Question: What style of plot is this figure drawn as?
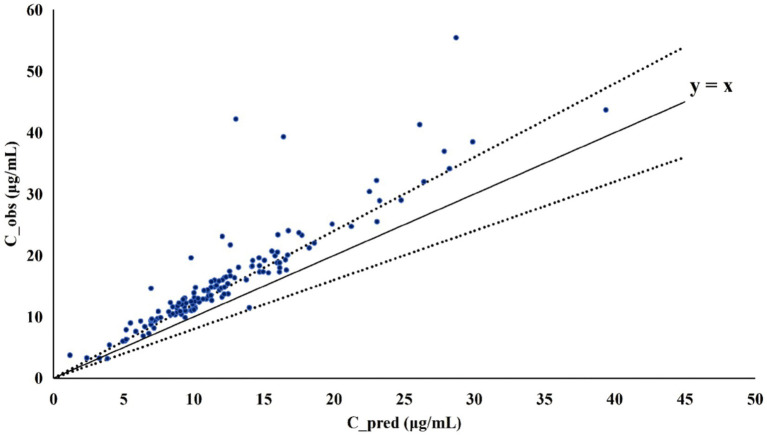
Answer: scatter